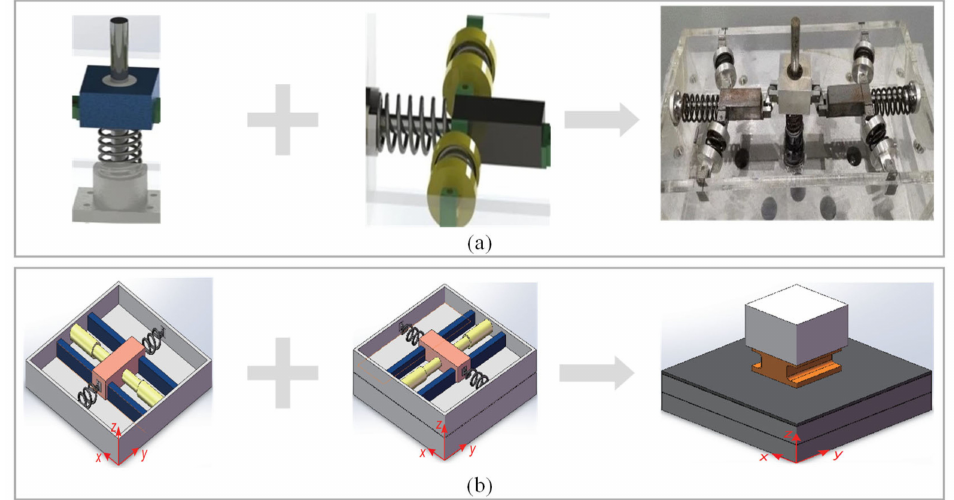
Figure 11. Development of mechanical springs: the dual QZS vibration isolator proposed by Wang et al. [30] based on the mechanical spring; the 2-DOF QZS vibration isolator proposed by Zhu et al. [31] based on the mechanical spring QZS isolator